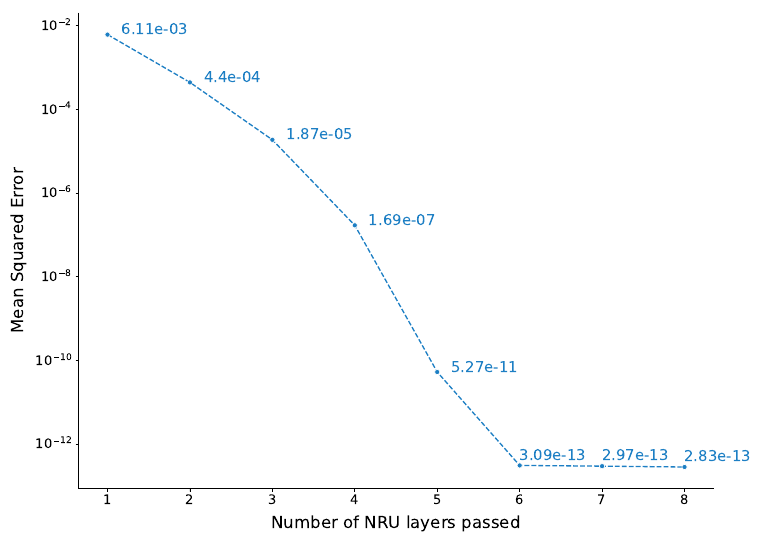
Figure 3. The degree of MSE change according to the number of NRU layers